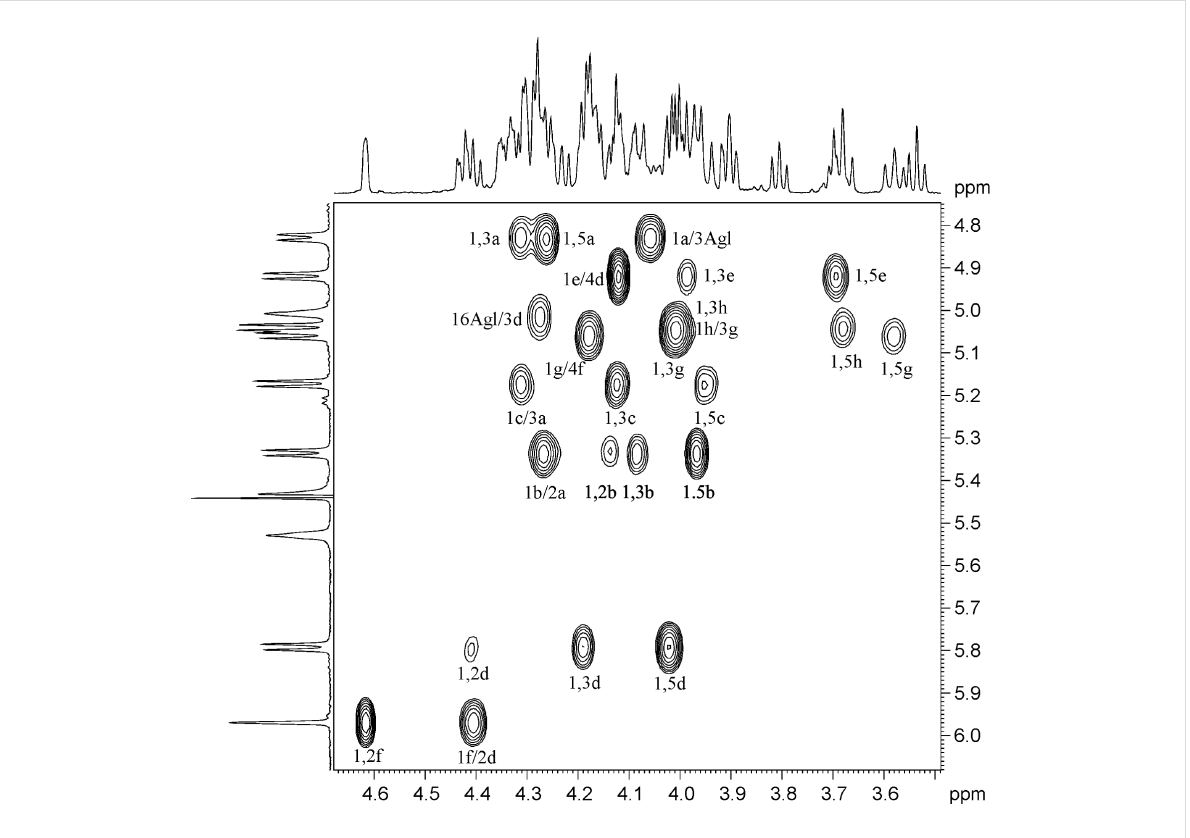
Figure 2: Part of a 2D ROESY spectrum of compound 1 . The corresponding parts of the 1 H NMR spectrum are shown along the axes. Arabic numerals refer to atoms in sugar residues denoted by letters, as shown for compounds 1 and 2 . Slashes are used for the designation of inter-residual interactions.